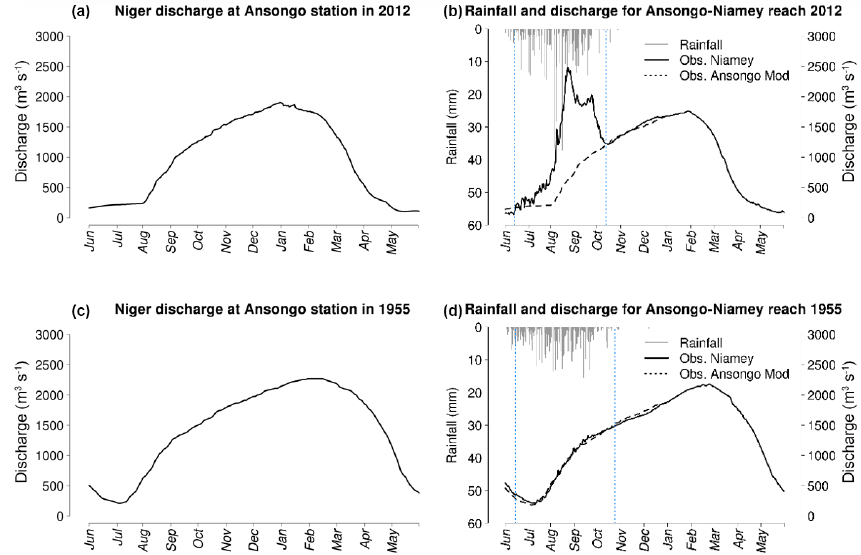
Figure 2. Discharge of the Niger in Ansongo station in 2012 (a) and 1955 (c) and discharge of the Niger in Niamey (black line) and Ansongo (dashed line) after morphing (see Sect. 2.3) in 2012 (b) and 1955 (d) . The downwards grey bars in (b) and (d) are the daily rainfall in Ansongo–Niamey reach basin. The dotted blue vertical lines in (b) and (e) indicate the beginning and the end of the red flood